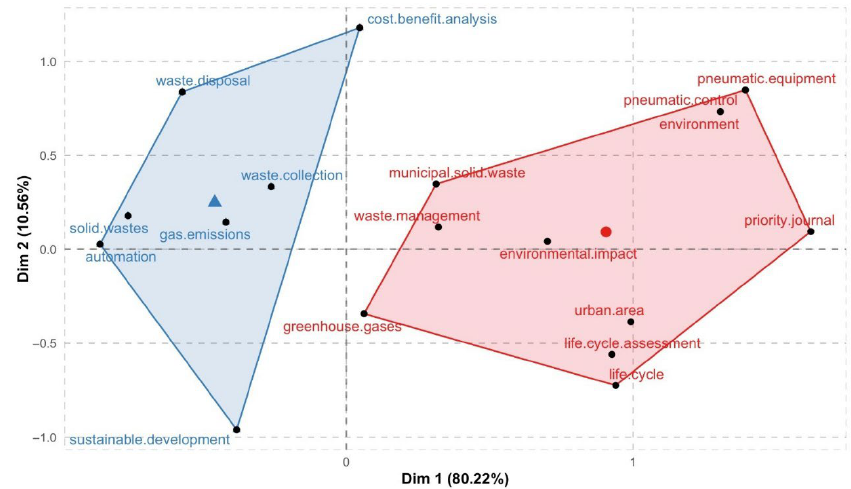
Figure 9. Multiple correspondence analysis method extracted from the database between 2009 and 2022 using R-studio software and bibliometrix library.